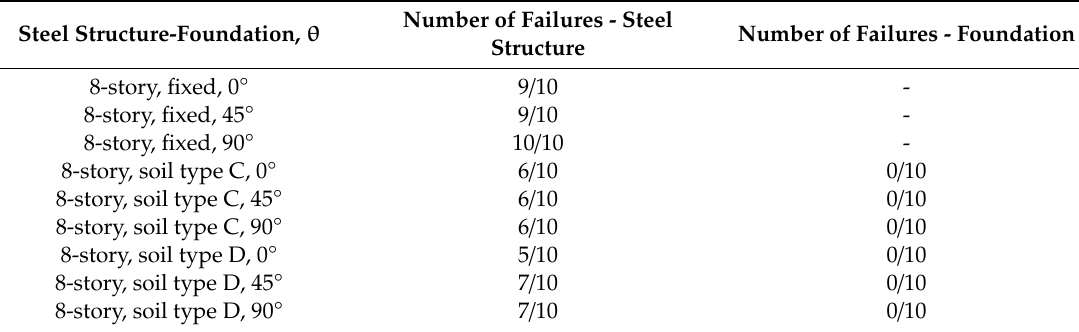
Table 11. The number of failures for the 8-story steel structure-foundation systems. Steel Structure-Foundation, θ